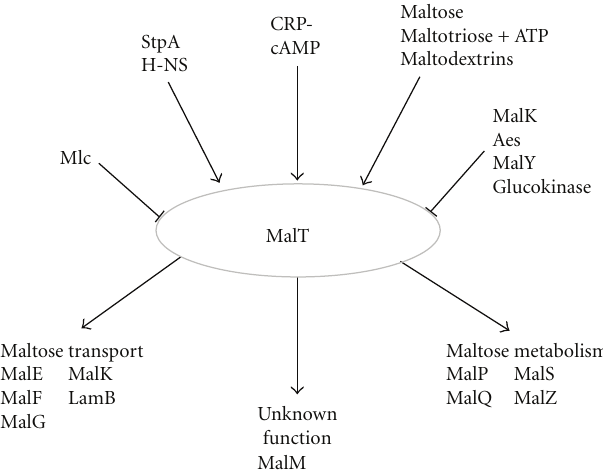
Figure 1: Regulation of MalT and its regulon. malT transcription is activated by the global regulator CRP-cAMP and repressed by Mlc. Translation of MalT is activated by H-NS and StpA. Activation of MalT activity can be attained by the binding of maltotriose, whereas it is inhibited by interaction with MalK, MalY, Aes, or glucokinase. Upon activation, MalT positively regulates expression of proteins that facilitate maltose uptake and